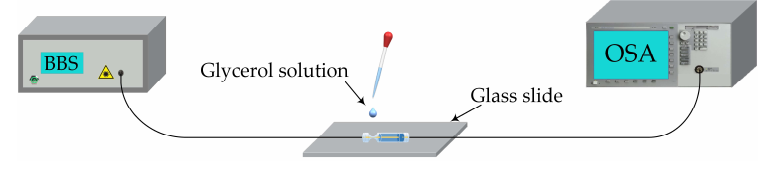
Figure 2. ( a ) Microscope image of the fabricated taper. ( b ) The cross-sectional morphology of double- cladding fiber (DCF). ( c ) The transmission spectrum of the single-pass (SP) structure.